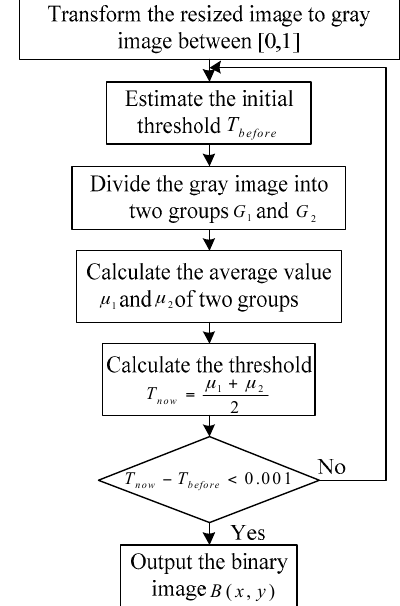
Figure 7. The procedure of transforming the resized image into binary image is displayed in this paper.